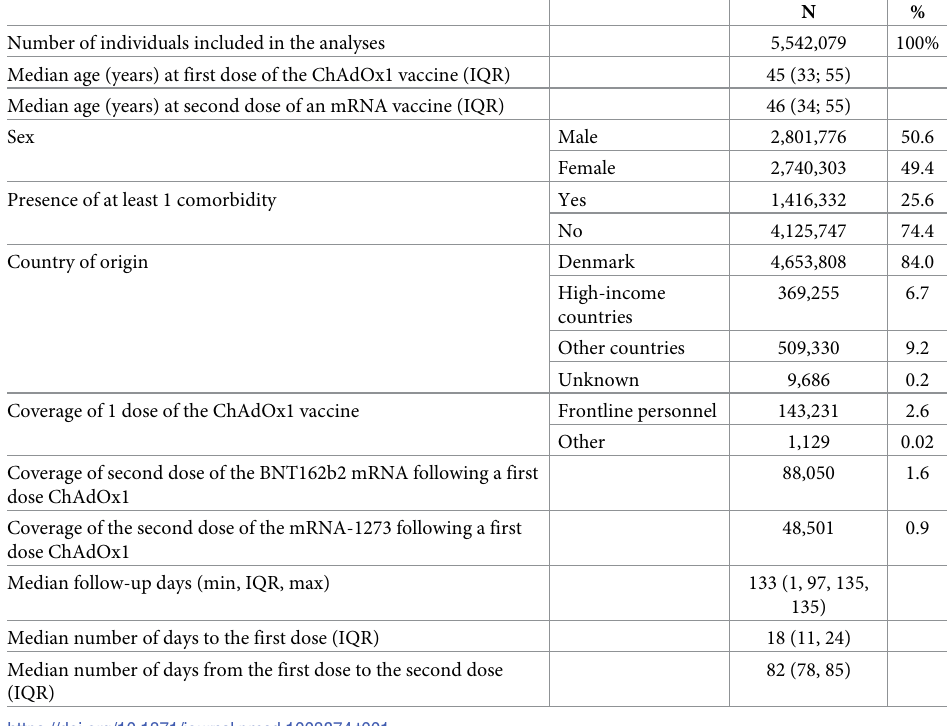
Table 1. Characteristics of the 5,542,079 individuals in the study population. Sex Male 2,801,776 50.6 Presence of at least 1 comorbidity Yes 1,416,332 25.6 Country of origin Denmark 4,653,808 84.0